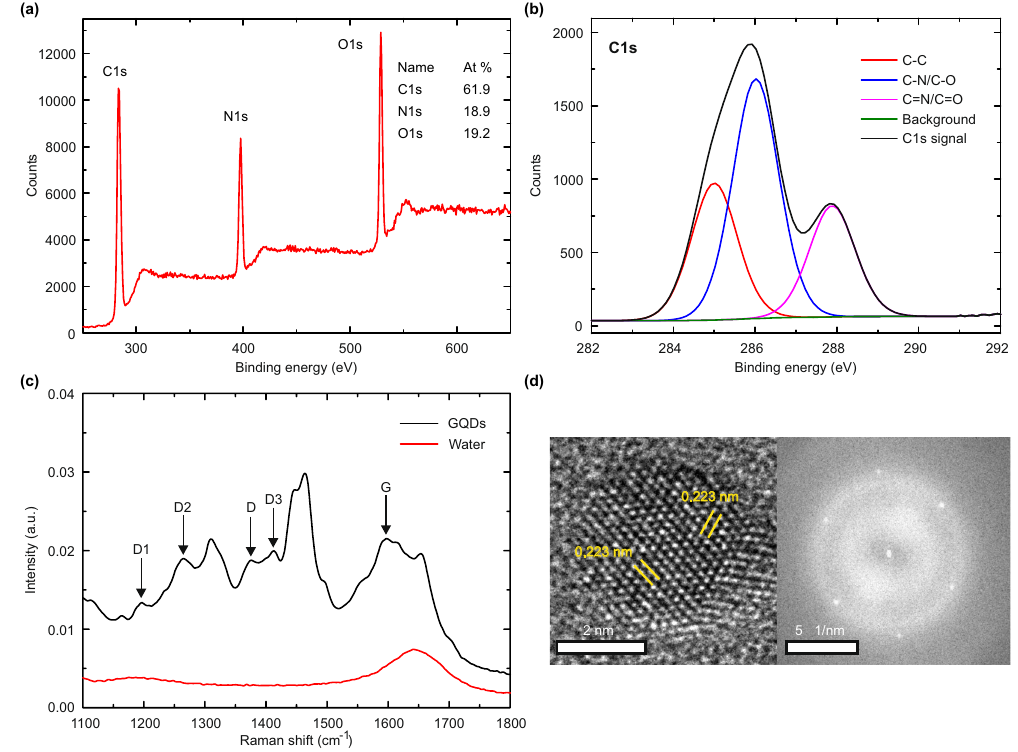
Figure 1. ( a ) Survey XPS spectrum of the GQDs quantifying the amount of C (61.9%), N (18.9%) and O (19.2%). ( b ) C1s XPS spectrum of the GQDs revealing C-C, C-O and C-N bonds. ( c ) Raman spectrum of the GQDs dispersed in water (black trace) and of water (red trace). ( d ) HRTEM image (left) of one GQD and the corresponding Fast Fourier Transform